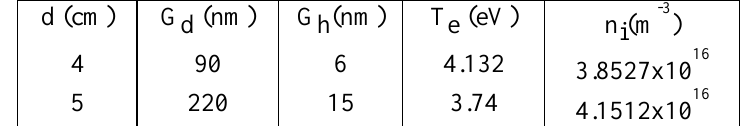
Table: Maximum and minimum values for gold average grain diameter, grain height, electron temperatures and ion densities at Id = 30